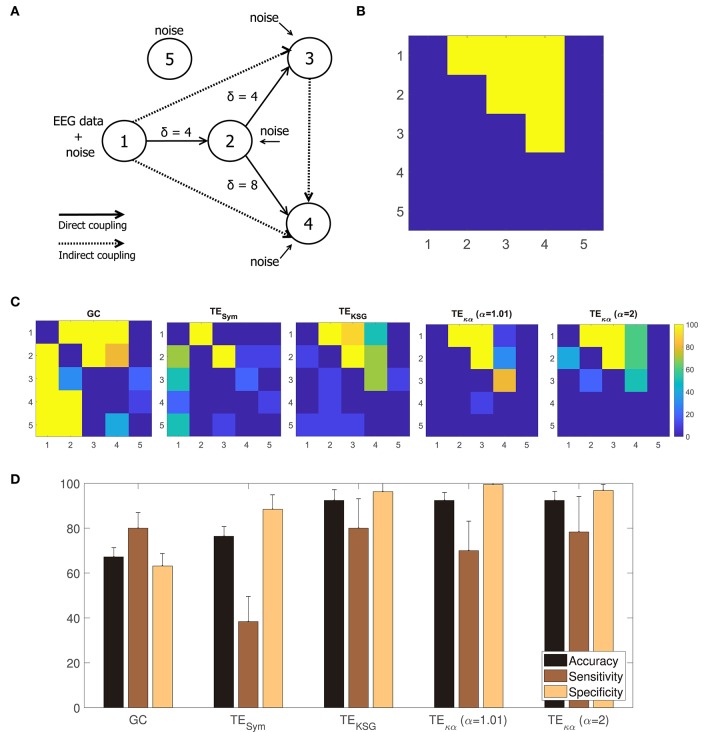
(A) Modified Kus model network coupling scheme. (B) Binary class matrix representation of the direct and indirect couplings in the modified Kus model network. (C) From left to right, statistically significant couplings according to a permutation test using trial randomized surrogates for GC, TESym, TEKSG, TEκα (α = 1.01), and TEκα (α = 2). (D) Accuracy, sensitivity, and specificity values obtained after comparing the statistically significant couplings shown in (C) with the matrix representation of the Kus model network presented in (A).